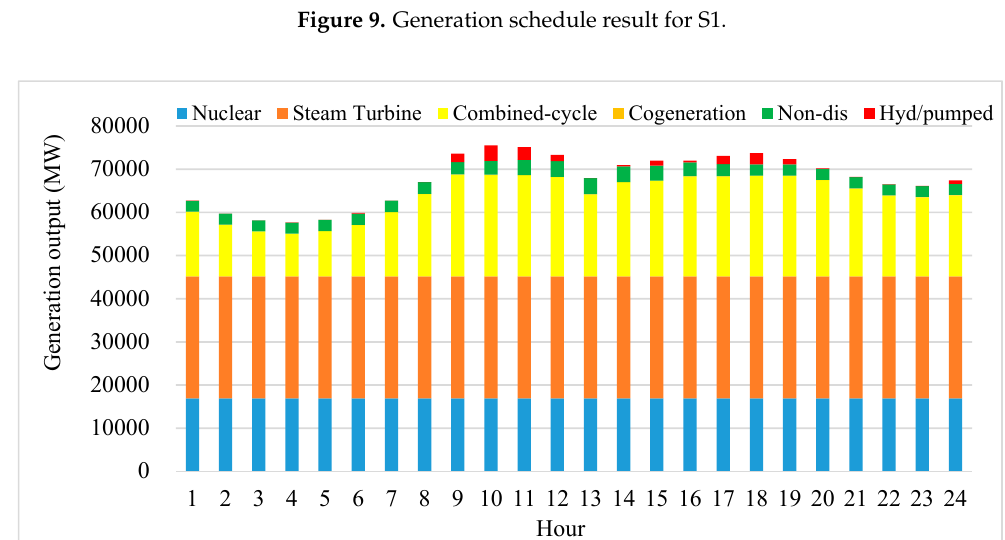
Figure 10. Generation schedule result for S19.